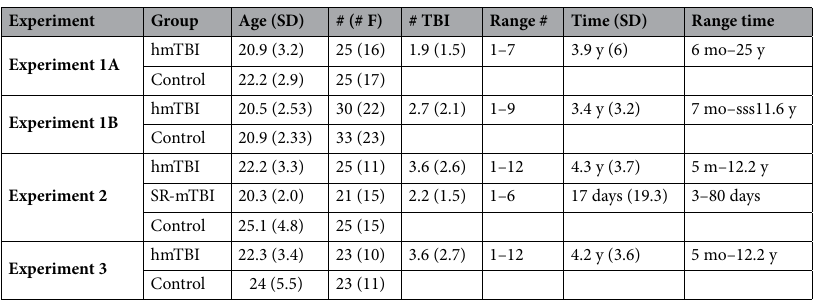
Table 1. Demographics for all experiments. Separate cohorts were tested in each experiment. The mean number of mTBIs and the Time (in years) since the most recent mTBI, averaged across participants. # number of mTBIs, F female, hmTBI history of mTBI group, mo months, Range # range of number of mTBIs, Range Time range of time since last mTBI, recent SR-mTBI recent sport related mTBI, SD standard deviation in years, y